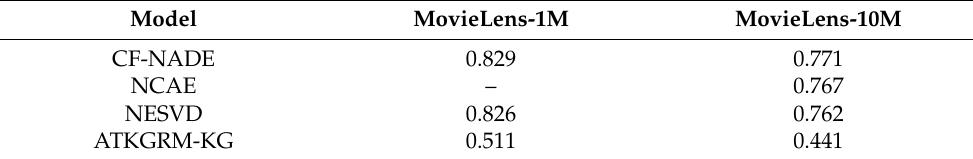
Table 3. RMSE of different models on MovieLens-1M and MovieLens-10M.